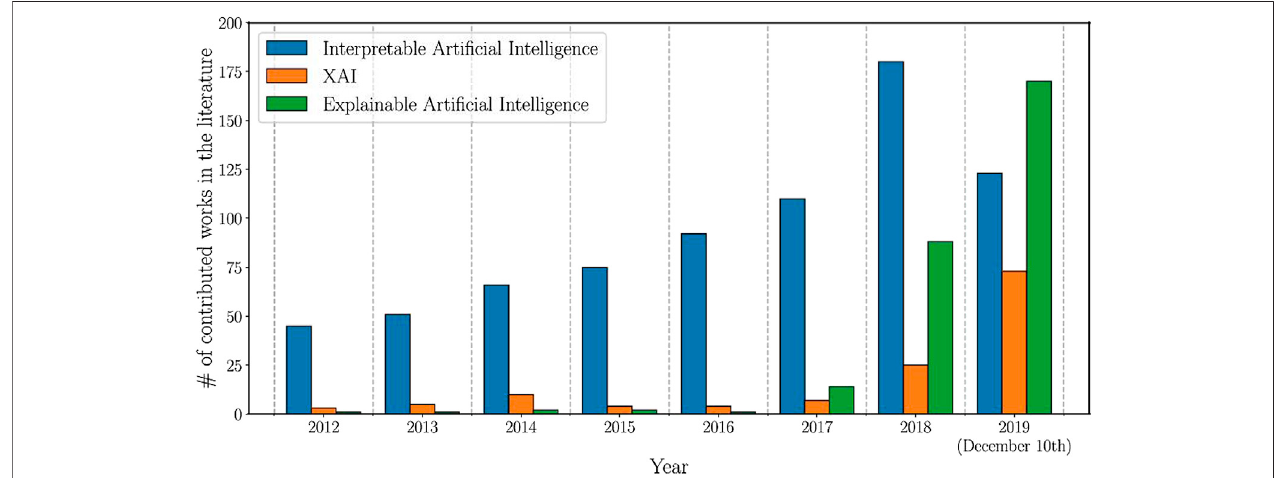
FIGURE 1 | Number of total publications related to the terms “ Interpretable Arti fi cial Intelligence ” , “ XAI ” , and “ Explainable Arti fi cial Intelligence ” between 2012 and 2019 (Arrieta et al., 2019).